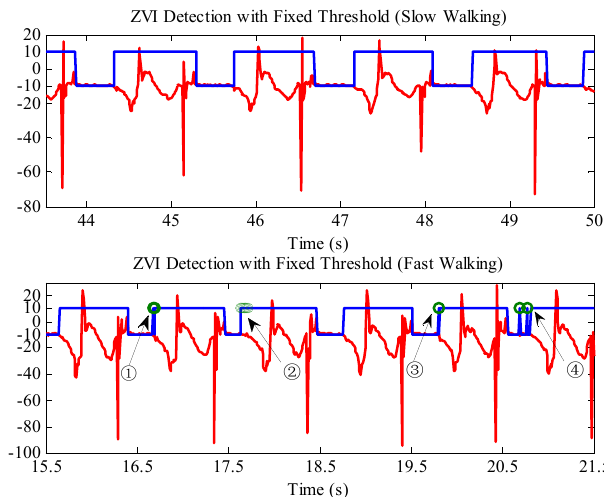
Figure 11. ZVI detection results with the fixed threshold method at different walking speeds. The red lines are the z axis accelerometer outputs. The blue lines are the ZVI detection results; − 10 represents ZVI; and 10 indicates non-ZVI.